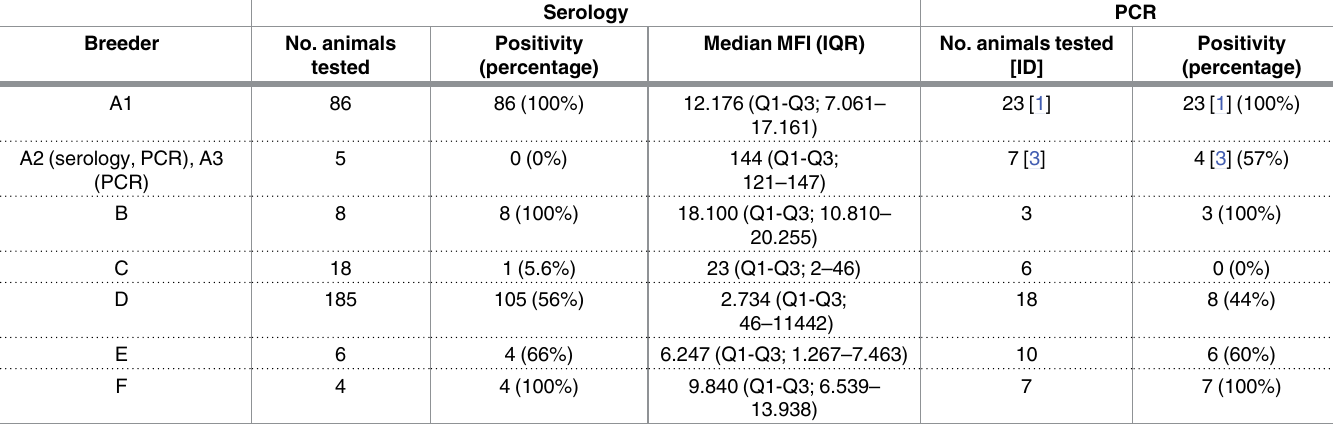
Table 4. MuAstV antibody and virus (RNA) prevalencein mice from